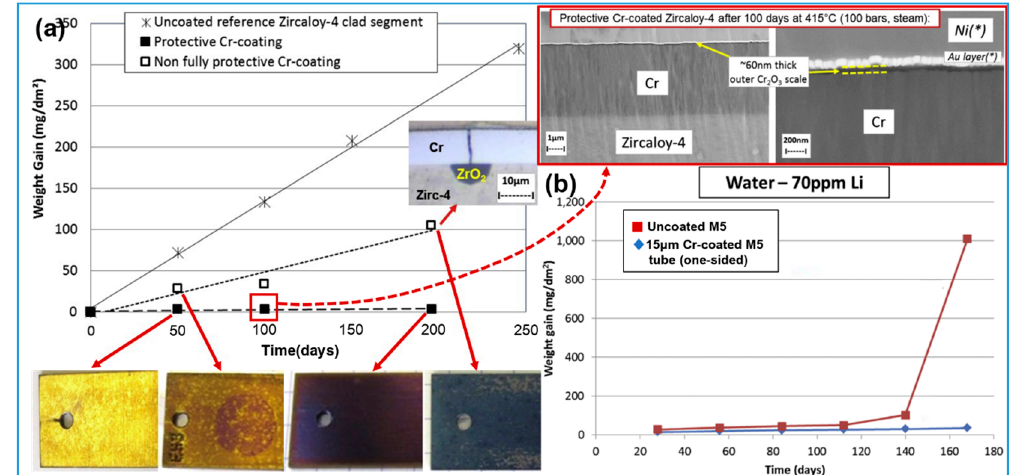
Figure 3. The results of corrosion test of Zr alloy cladding with PVD Cr coating. Reproduced from the work in [2] ( a ) and the work in [16] ( b ) with copyright permission from